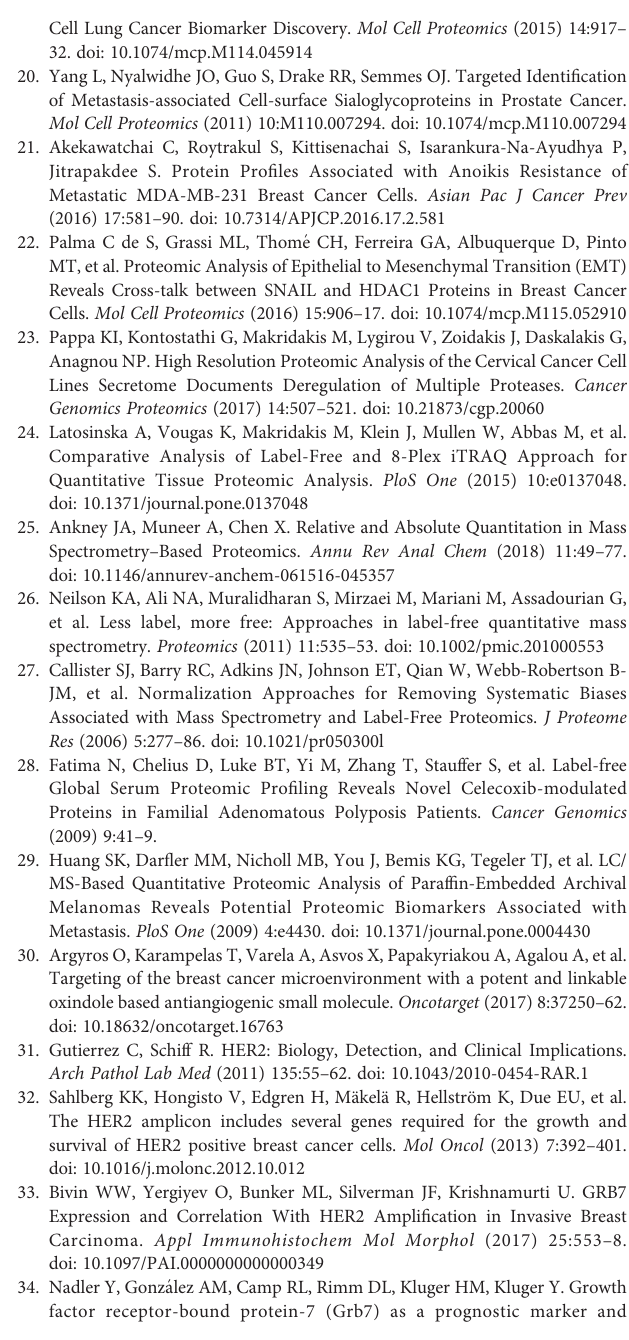
lists of all the membrane-associated proteins found in four replicates of the HCC- 1954 cells compared to four replicates of the MCF-10A cells along with their Normalized Areas. Bold letter proteins represent the top 30 candidate protein targets shown in the Table 1 of the main text. Supplementary Table 2 | Complete lists of membrane proteins found in the MDA-MB-231 cells and MCF-10A cells (provided as a separate excel fi le). Combined lists of all the membrane-associated proteins found in four replicates of the MDA-MB-231 versus the MCF-10A cells along with their Normalized Areas. Bold letter proteins represent the top 30 candidate protein targets shown in the Table 2 of the main